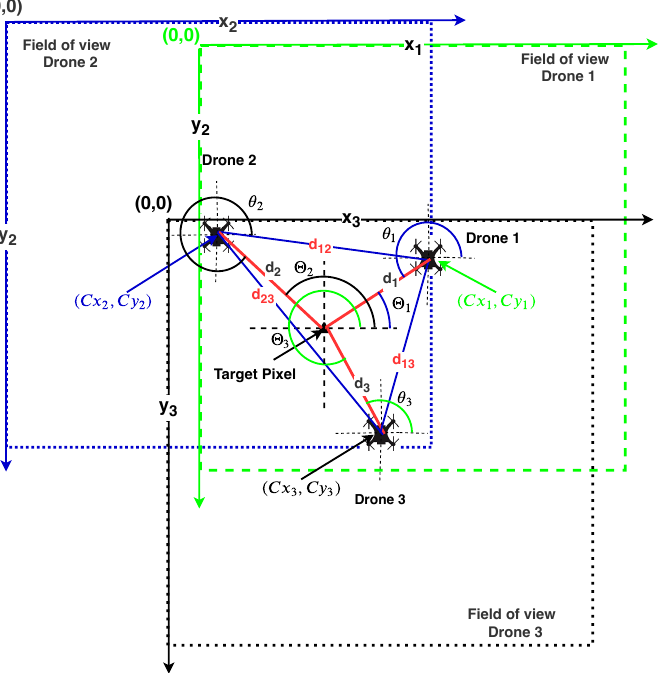
Figure 2. Two-dimensional conceptual diagram for parameter measurements between the image centers of the target and the